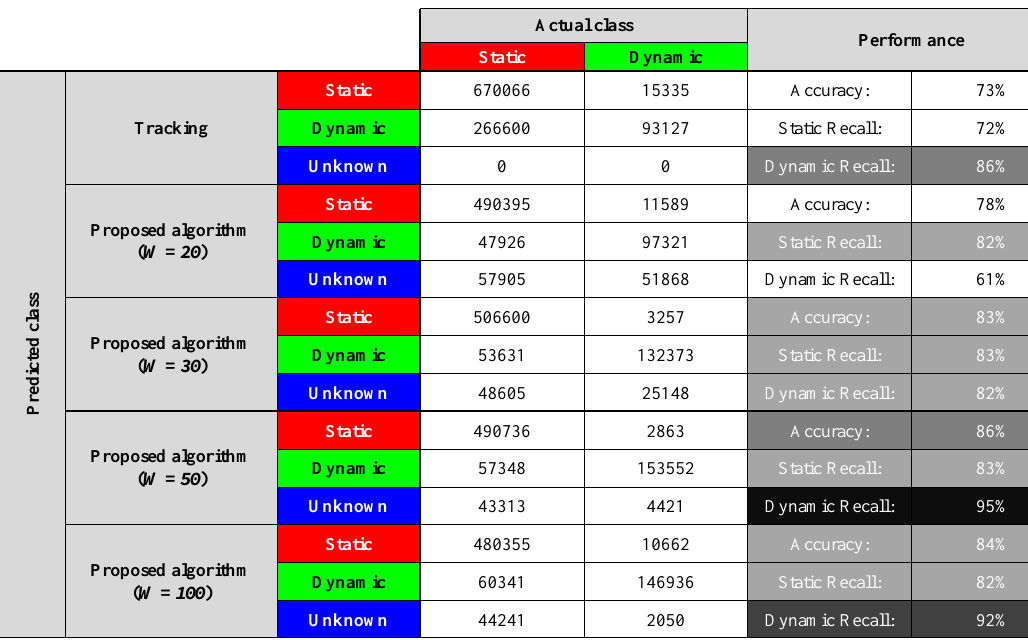
Figure 11. ( a ) Test site with moving cars and stationary road structures and ( b ) classification results of point-wise LiDAR motion segmentation. Table 2. Confusion matrices of the tracking-based algorithm and the proposed algorithm with various time window